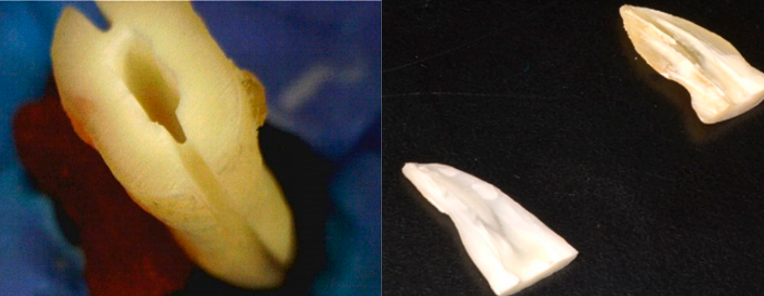
Figure 1. Longitudinal grooves were made on mesial and distal surfaces of the root using a diamond disk.